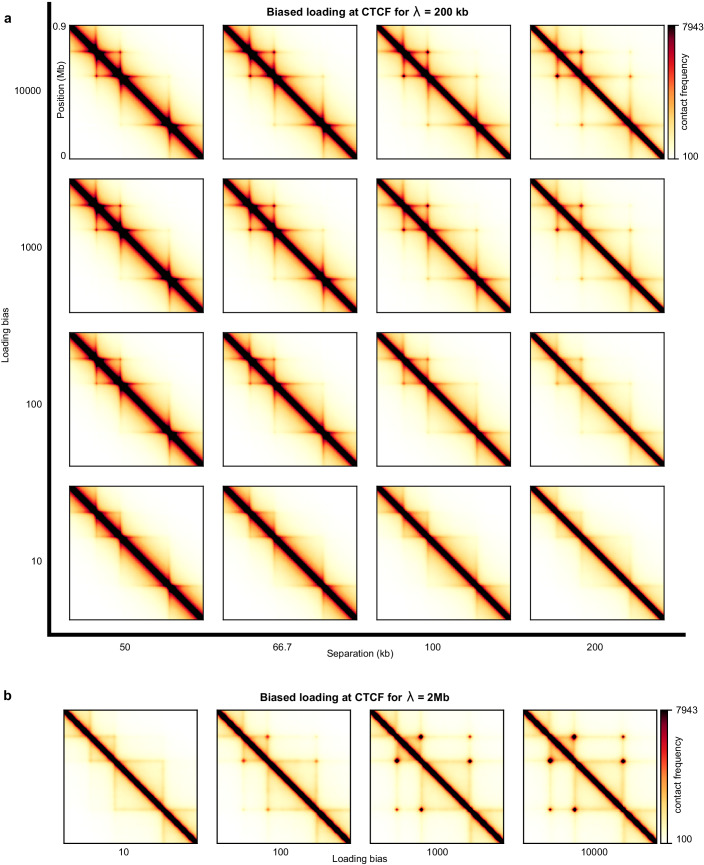
Sweep of the separation and the processivity of LEFs for one-sided LEFs with a loading bias at CTCF sites.(a) Sweep of the separation between LEFs, d, for one-sided LEFs that load 1000 times more likely at a CTCF site as compared to an arbitrary site within the TAD, where each CTCF site has two loading sites. For the smallest TAD (which consists of 100 monomers, 200 kb), this loading bias implies that at most 95% of all LEFs load at a boundary. For the largest TAD (which has a size of 200 monomers, 400 kb), at most 90% of the LEFs load at a boundary. Note that, once a boundary is occupied, a LEF is forced to load somewhere else, and therefore we only give an upper estimate for the fraction of LEFs loaded at a boundary. The processivity is λ = 200 kb for all panels. (b) Sweep of the loading bias for λ = 2 Mb, d = 200 kb.